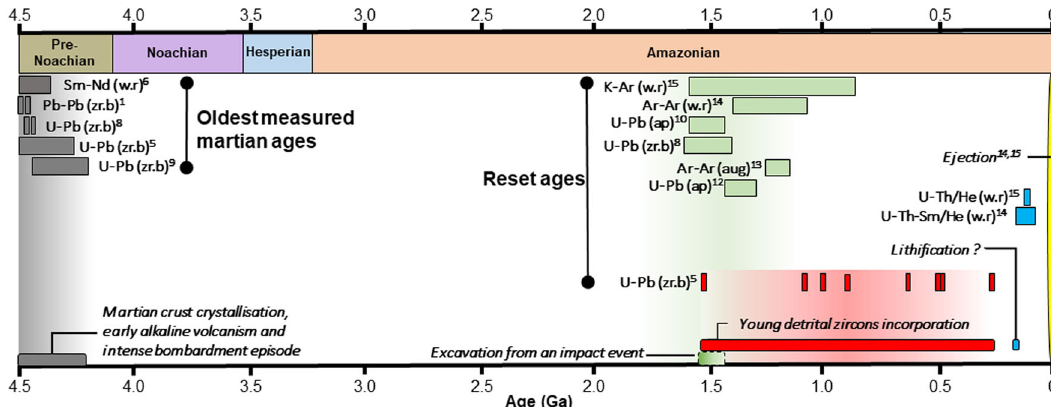
Fig. 1 Summary of NWA 7034 and paired stone radiometric ages, and chronology of major events experienced by the breccia. Dates from each study are reported in Supplementary Data 1. The ejection event is constrained from 22 Ne/ 21 Ne cosmic ray exposure ages 12, 13 . Whole rock (w.r), zircon and or baddeleyite (zr.b), apatite (ap), and augite (aug) on which ages have measured are also mentioned. The different chronometers used in these studies are reported (Sm-Nd, Pb-Pb, U-Pb, K-Ar, U-Th/He, U-Th-Sm/He). Note that green, red and blue boxes correspond to resetting ages of the noted chronometer. Reset ages in green are widely interpreted as the disruption induced by an impact-derived heating event that has excavated the oldest components of the breccia ~1.5 ago 9, 11, 23, 26 , although its precise age is still unconstrained due to the wide range of isotopic dates reported in the